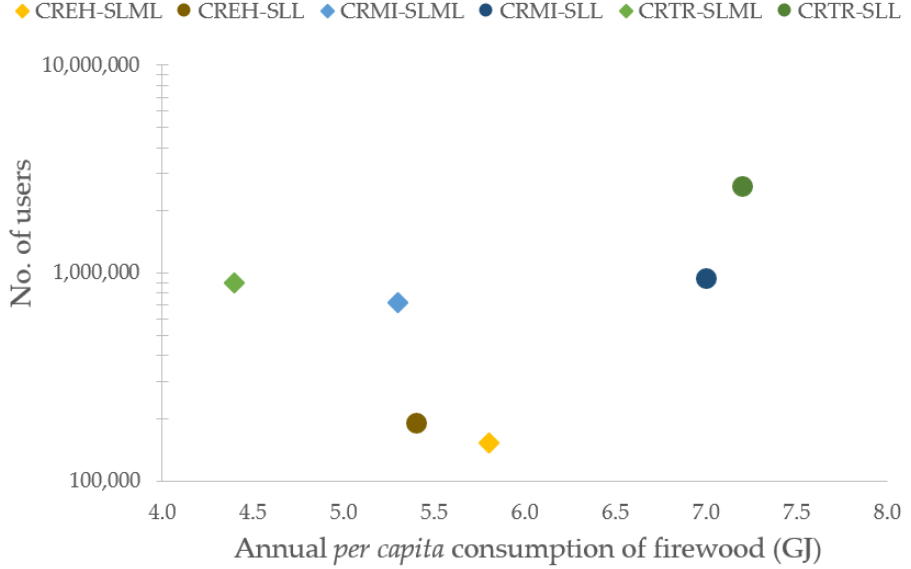
Figure 7. Annual per capita consumption of firewood and number of MPU in socioeconomic levels, by climate region. EH, extreme heat; MI, mild; TR, tropical; ML, moderately low; L, low. Source: Own elaboration.